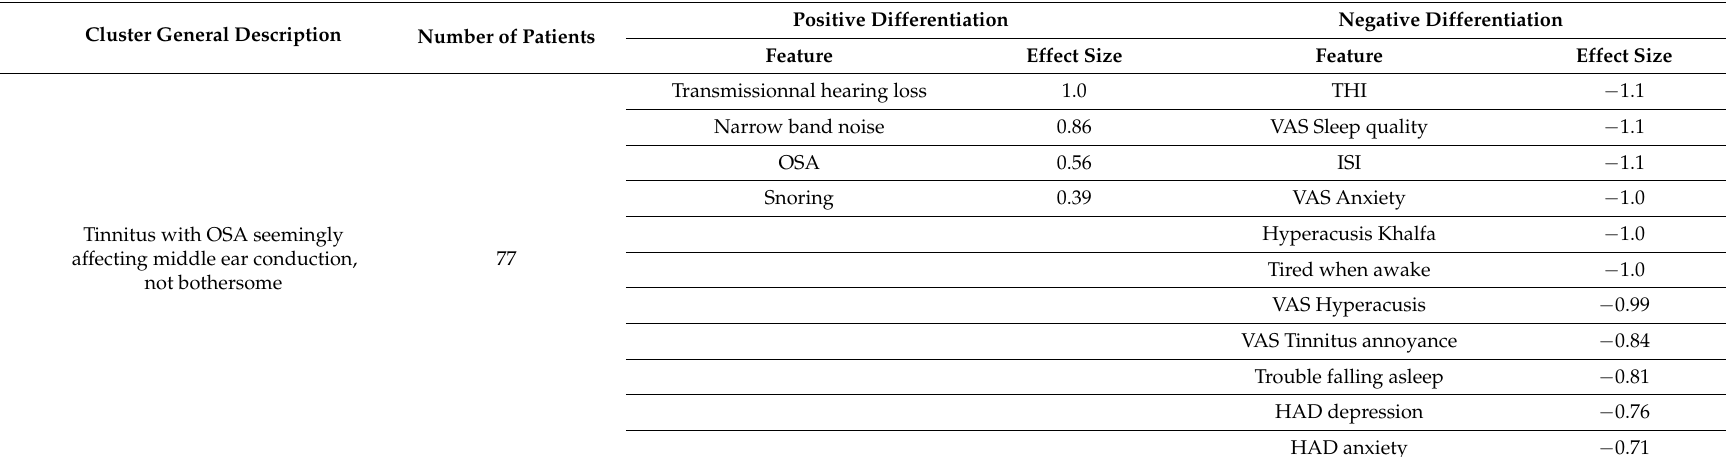
Table 7. Cont. Individual Clusters Characteristics of the Finally Selcted